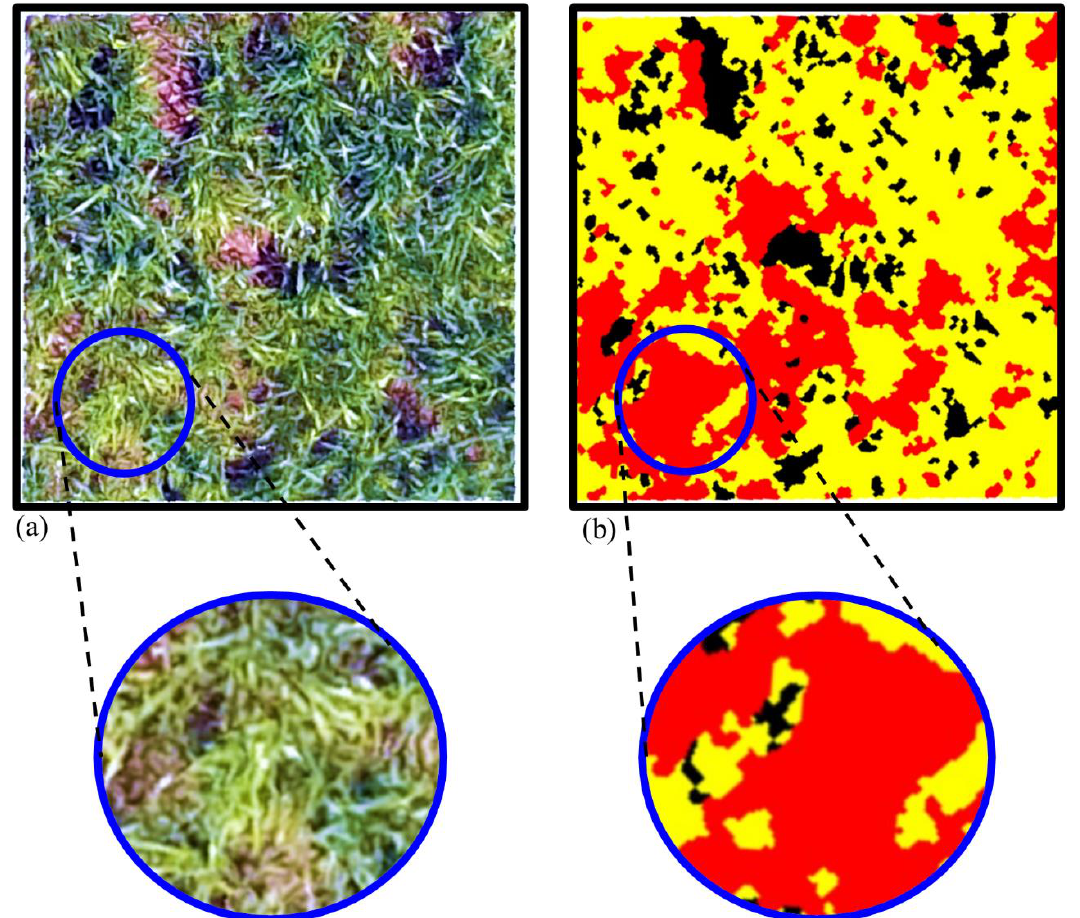
Figure 4. An example imagery showing Italian ryegrass coverage in wheat in a moderate density experimental unit (i.e., 1 m × 1 m quadrat) established in this study ( a ) and its corresponding classified map ( b ). The imagery for the experimental unit was classified using the best feature model determined in the study. The zoomed circles beneath the panels a and b represent a specific section of the imagery and its corresponding map. The red, yellow, and black colors in the map represent ryegrass coverage area, non-ryegrass vegetation, and baregound and shadow areas, respectively. For model #10, the user-defined classes Bareground and Shadow were classified with the highest precision, recall and F-score (>98%), compared to the other classes namely Ryegrass-A, Ryegrass-B